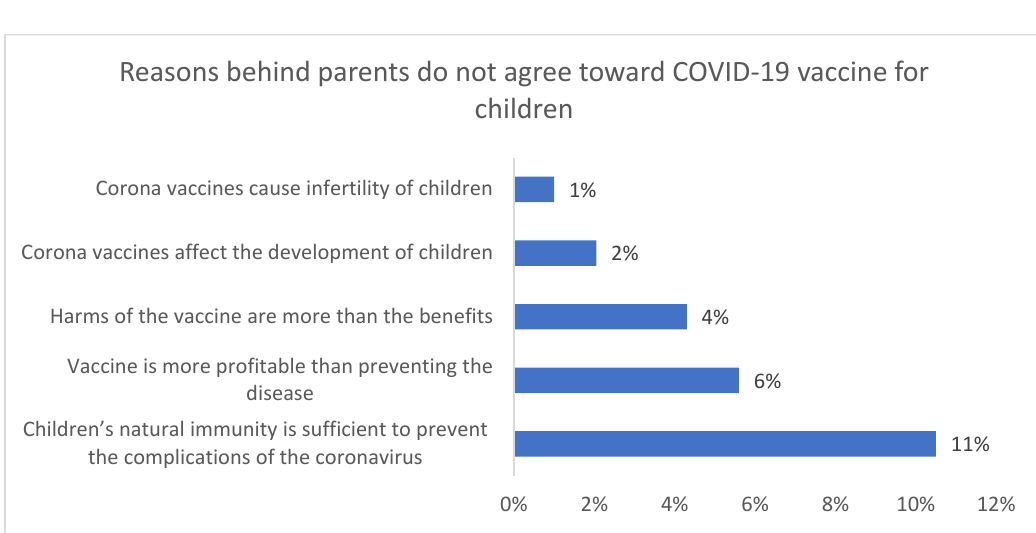
Figure 1. Reasons for parents’ agreement to vaccinate their children for COVID-19.